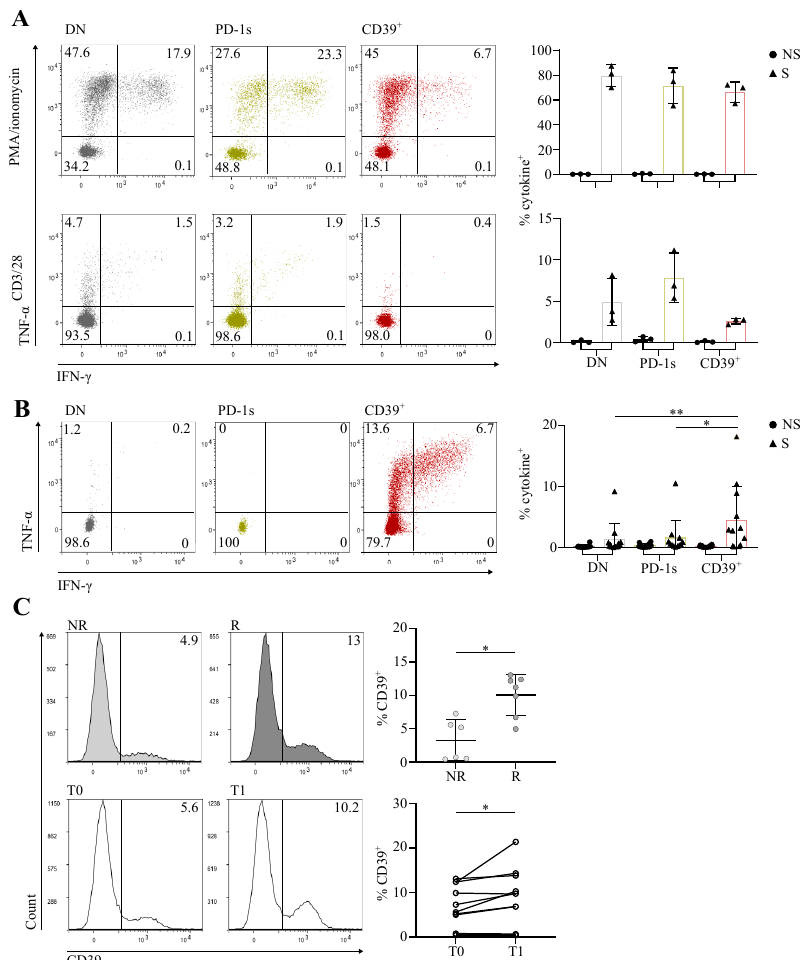
Figure 3. The circulating PD-1 + CD39 + memory CD4 T-cell subpopulation contains tumor-Ag-specific exhausted cells and predicts the response to PD-1/PD-L1 axis blockade. ( A ) CD4 T cells isolated ex vivo from PBMCs of HNSCC patients ( n = 3) were sorted by flow cytometry into the memory Tconv PD-1 - CD39 - (DN), PD-1 + CD39 - (PD-1s), and CD39 + populations. Cells were stimulated (S) with PMA/ionomycin (upper panels) or plate bound anti-CD3 and antiCD28 mAbs (lower panels), or not stimulated (NS), and cytokine production was assessed by intracellular staining. Representative dot plots of IFN- γ and TNF- α staining are shown for the three populations from one patient and the proportions of cytokine + (IFN- γ + and/or TNF- α + ) cells are summarized for all cell populations and patients. ( B ) CD4 T cells isolated ex vivo from PBMCs of CC or HNSCC patients with human- papillomavirus (HPV) + tumors ( n = 9) were sorted by flow cytometry into the memory Tconv DN, PD-1s, and CD39 + populations. Sorted cells were stimulated in vitro with HPV E6 and E7 peptide pools and cultured for 20 days, cultures were restimulated (S) or not (NS) with the same peptide pools, and cytokine production was assessed by intracellular staining. Representative dot plots of IFN- γ and TNF- α staining of stimulated cultures are shown for the three populations from one patient, and the proportions of cytokine + (IFN- γ + and/or TNF- α + ) cells are summarized for all cell populations and patients, with (S) or without (NS) peptide restimulation. ( C ) CD4 T cells, isolated ex vivo from pre- and posttreatment PBMCs of CC and anal cancer patients with HPV + tumors receiving anti-PD- 1/PD-L1, were stained and analyzed by flow cytometry. Upper panel, histograms show examples of CD39 expression in memory Tconv in immunotherapy non-responder (NR) and responder (R) patients in pretreatment PBMCs, and the proportions of CD39 + cells among pretreatment memory Tconv are summarized for all patients ( n = 13). Lower panel, histograms show examples of CD39 expression in memory Tconv from pretreatment (T0) and posttreatment (T1) PBMCs from one patient, and the proportions of CD39 + cells among pre- and posttreatment memory Tconv are summarized for all patients ( n =